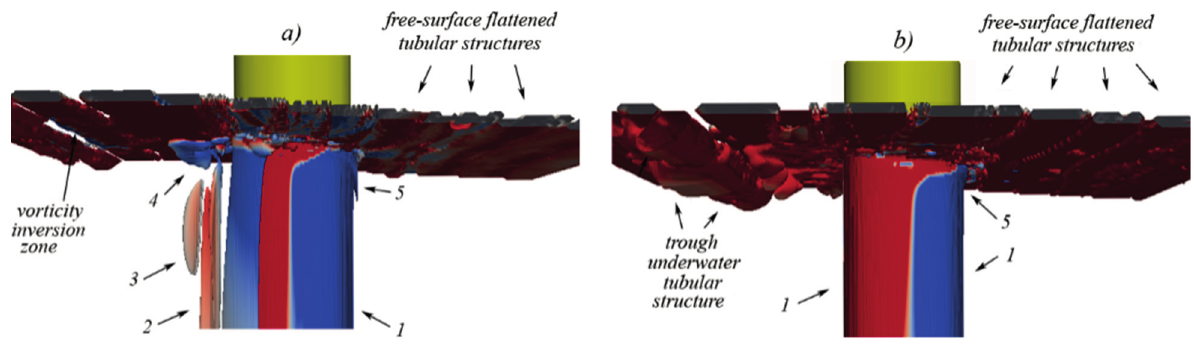
Figure 20. Close-up at the cylinder surface of viscous-flow structures as obtained from the solution of the Navier-Stokes equations. Side view: ( a